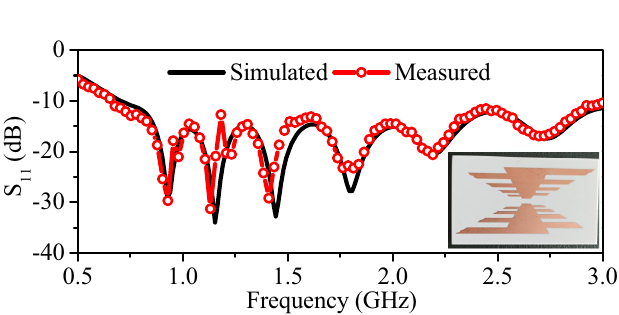
Figure 13. ( a ) Schematic diagram of WPT transmitter, and ( b ) Wireless powering setup of the implant ( d = 60 mm).